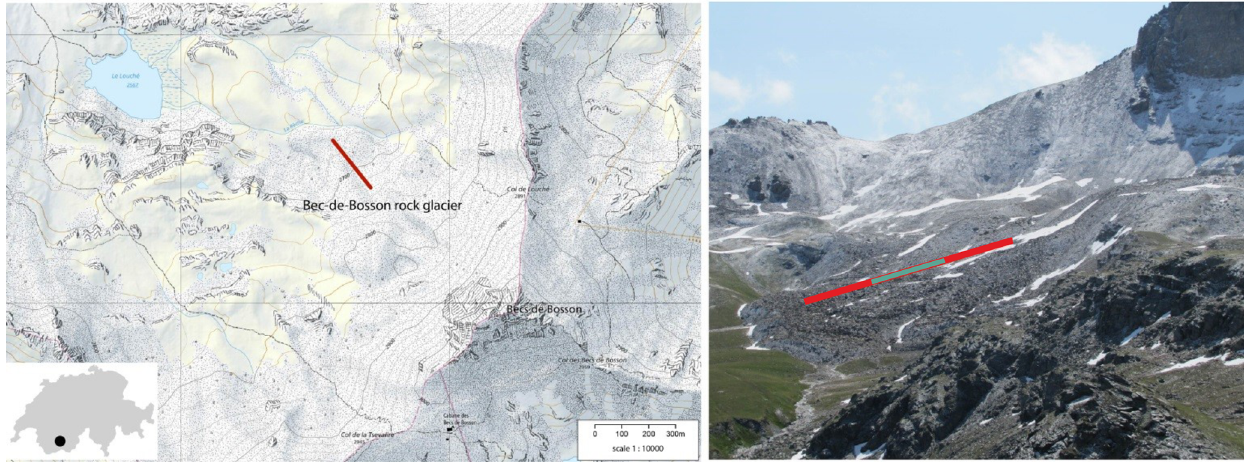
Figure 1. Map and photograph of the Becs de Bosson rock glacier. The red line on map and photograph marks the position of the full geophysical profile, while the green line on the photo shows the joint ERT/RST profile, which is used for the 4PM analysis of this study. Map source: Swiss Federal Office of Topography